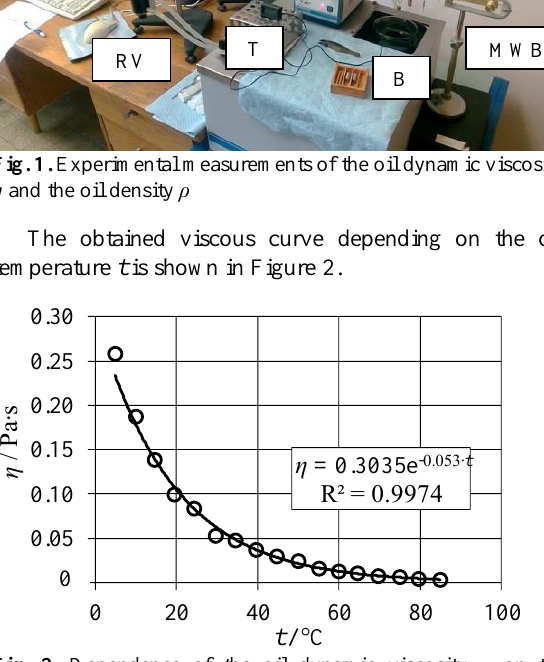
Fig. 2. Dependence of the oil dynamic viscosity η on the temperature t